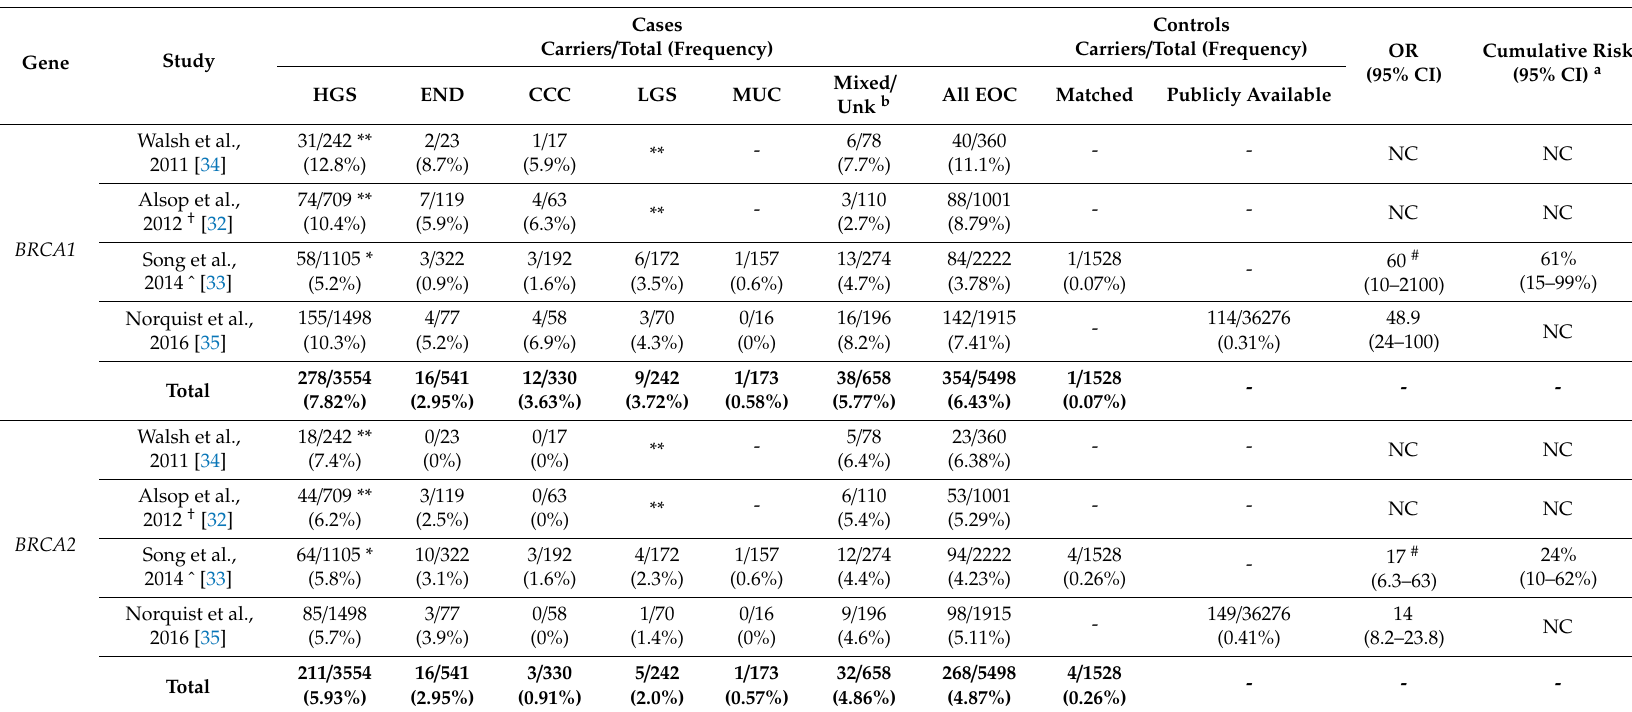
Table 1. Frequency of germline pathogenic variants in BRCA1 / 2 in epithelial ovarian cancer (EOC) histotypes, in cases from population studies.